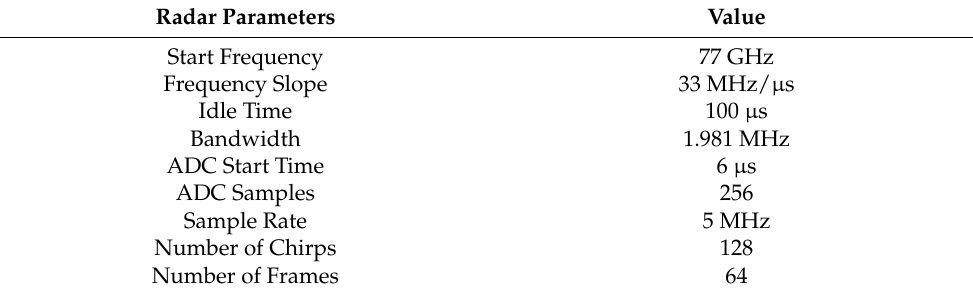
Table 1. Parameters of two radar configuration.